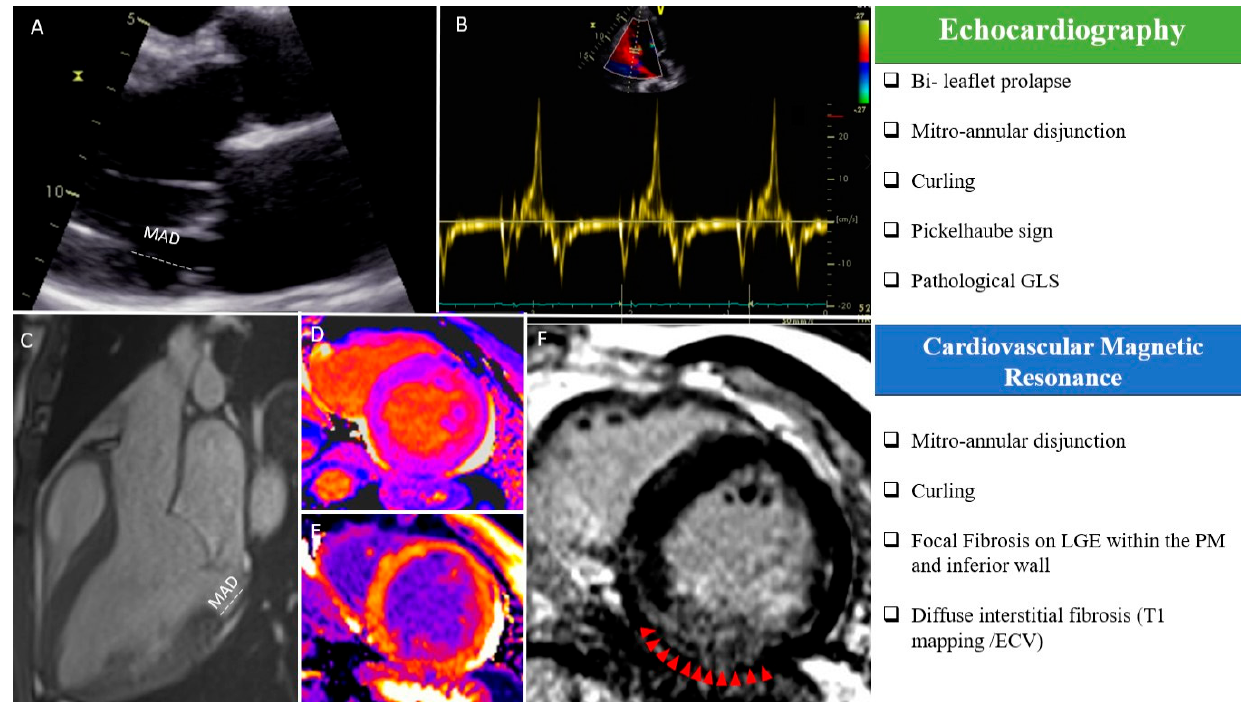
Figure 1. “Red Flags” in echocardiography and cardiac magnetic resonance imaging (CMR): ( A ) MAD measured in a parasternal long-axis view (transthoracic echocardiography); ( B ) “Pickelhaube sign” during transthoracic echocardiography; ( C ) MAD measured in a steady-state free precession three-chamber view during CMR; T1 mapping native ( D ) and after gadolinium injection ( E ); macroscopic fibrosis in the inferior basal wall highlighted with red arrows in a free-breathing LGE sequence ( F ). ECV, extracellular volume; LGE, late gadolinium enhancement; MAD, mitro-annular disjunction; PM, papillary muscle, GLS: Global Longitudinal Strain.